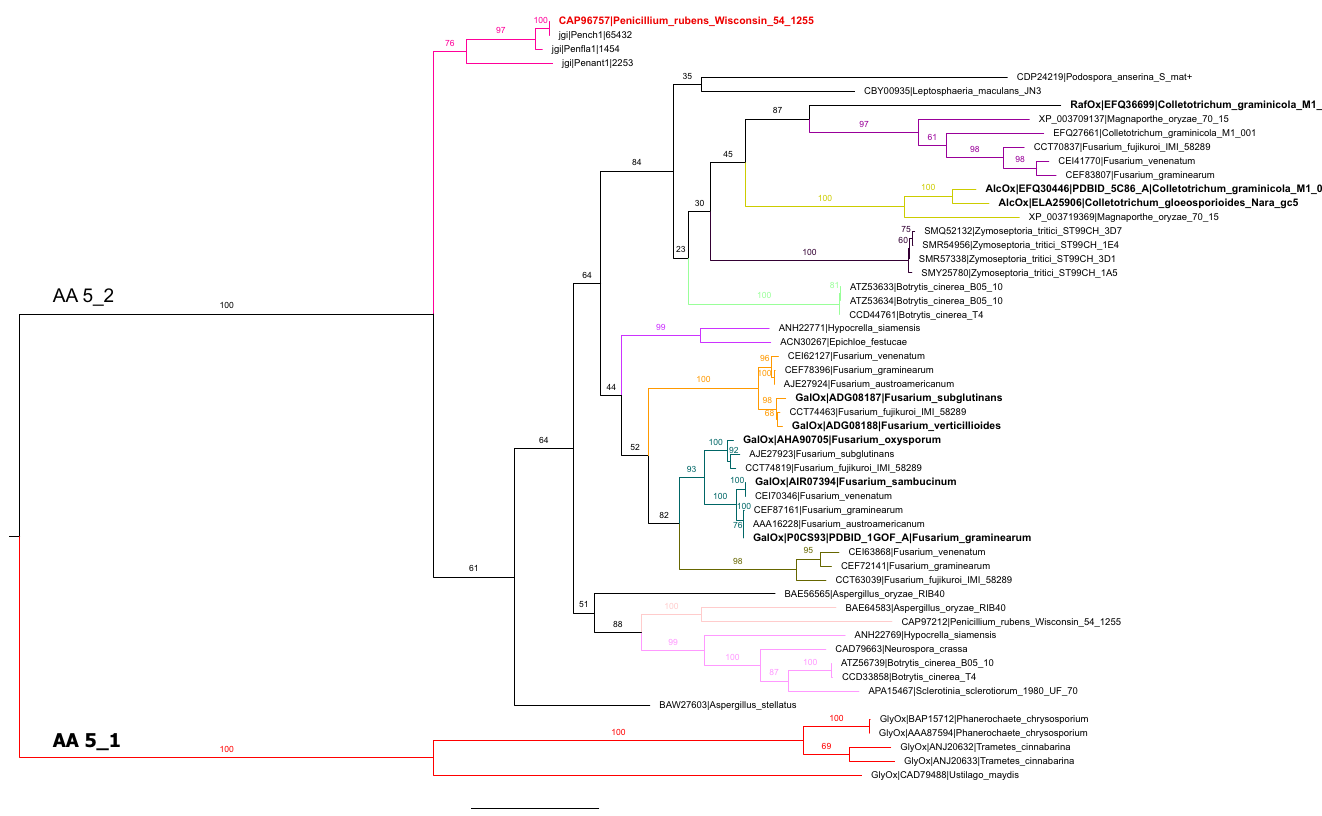
Fig 1. Phylogenetic tree of AA5_2. Subfamilies 1 (AA5_1) and 2 (AA5_2) are indicated. GenBank identifiers (Uniprot identifier P0CS93 in the case of the F . graminearum ) are given for all sequences available in the public CAZy database [18] as of May 2018. JGI protein identifiers are given for Ascomycota homologs of Pru AA5_2A. Sequences for which biochemical data is available are displayed in bold and indicated as glyoxal oxidases (GlyOx) [27–31], galactose oxidases (GalOx) [26,32],general alcohol oxidases (AlcOx) [16] and raffinose oxidase (RaOx) [6]. When available the three dimensional structures are also indicated with the corresponding PDBID. Sequences were aligned using MUSCLE and the tree was constructed using RAxML v8.2.10. The robustness of the branches was assessed by the bootstrap method with 100 replications. Bootstrap values are indicated at each branch supporting the different subgroups. Subgroups were formed by exhibiting bootstrap values > 75 and colored